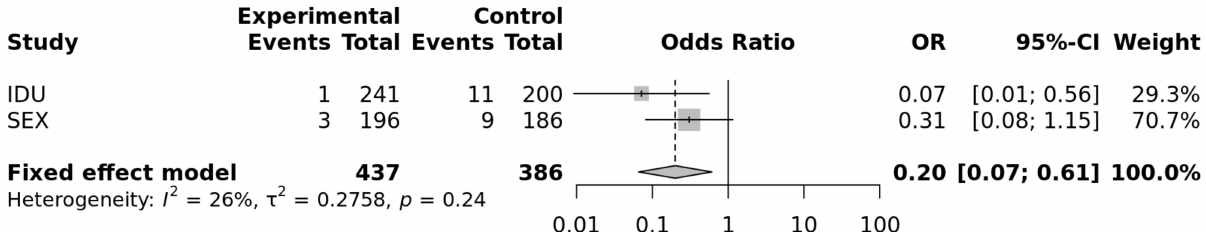
Figure 1. Forrest plot of meta-analysis of the sexual and IDU populations: OR and 95% Confidence interval and fixed-effect meta-analysis. p = 0.0044 for a recessive model of the protective allele (https://metagenyo.genyo.es/ (accessed on 13 June